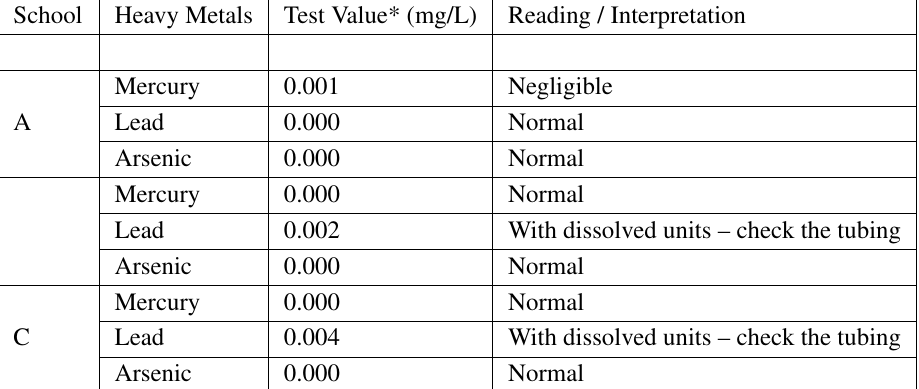
Table 2. Heavymetal test on water samples from WVMs from selected public schools in Cebu City